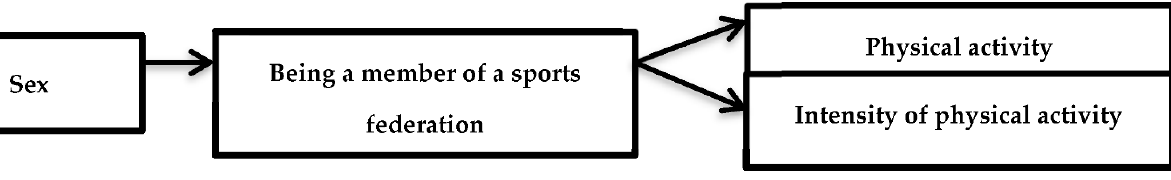
Figure 2. Causal model on physical activity and its intensity.